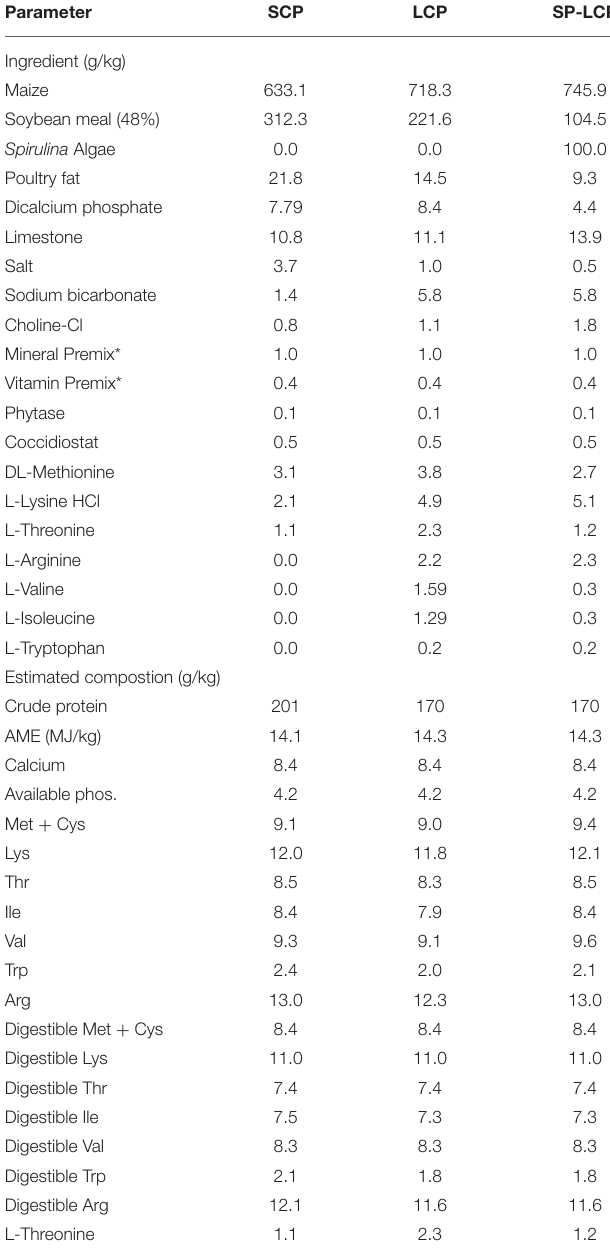
TABLE 1 | Composition of experimental